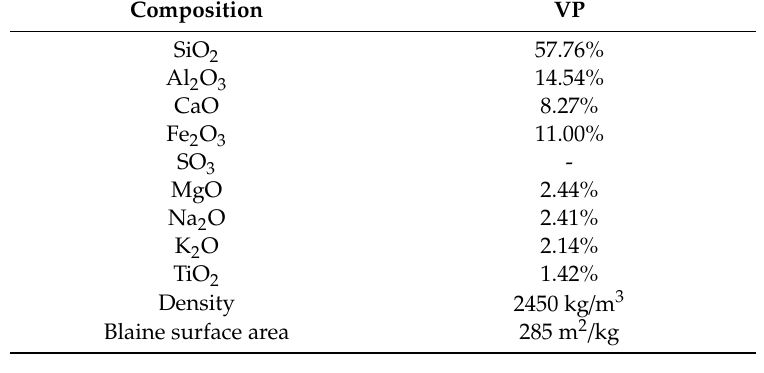
Table 1. Physical and chemical properties of VP.